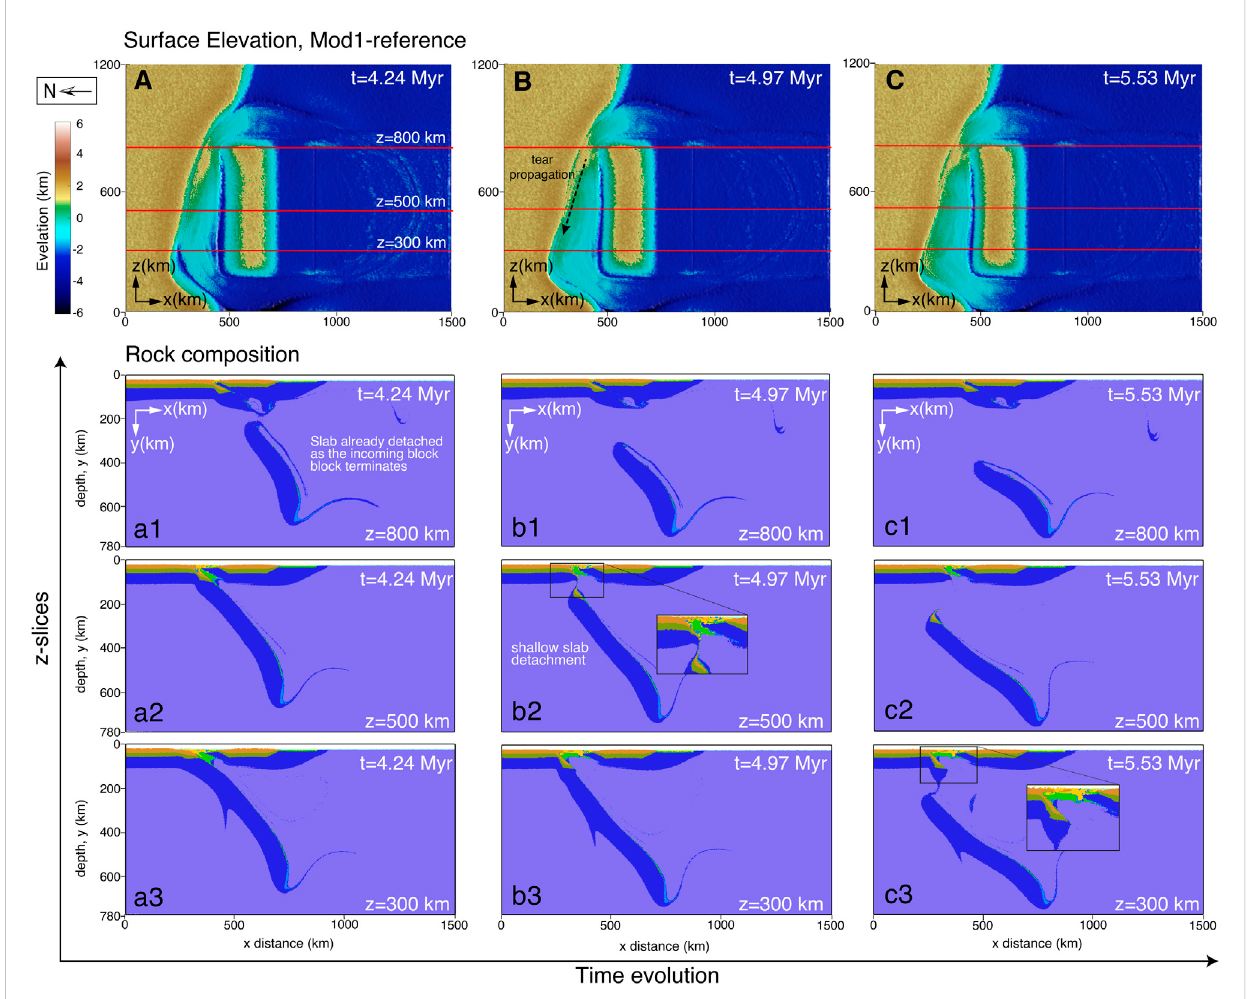
FIGURE 4 Evolutionofthereferencemodel(Mod1-reference)shownassurfacetopography (A,B,C) andlithology(a1-3,b1-3,andc1-3).Thecolourcodingfor thelithology slices isthesameas inFigure 2.Set (A) show thestageatwhich thecontinental-continentalcollisioncauses theincoming continental block to stop completely. The slab has already started to detach on the eastern side (z = 800 km) by this point. In Set (B) , the slab is half-torn with the attached portion of the slab still exerting slab-pull force. In Set (C) , the tearing is approaching the western most side of the slab. Here the tearing/pinching